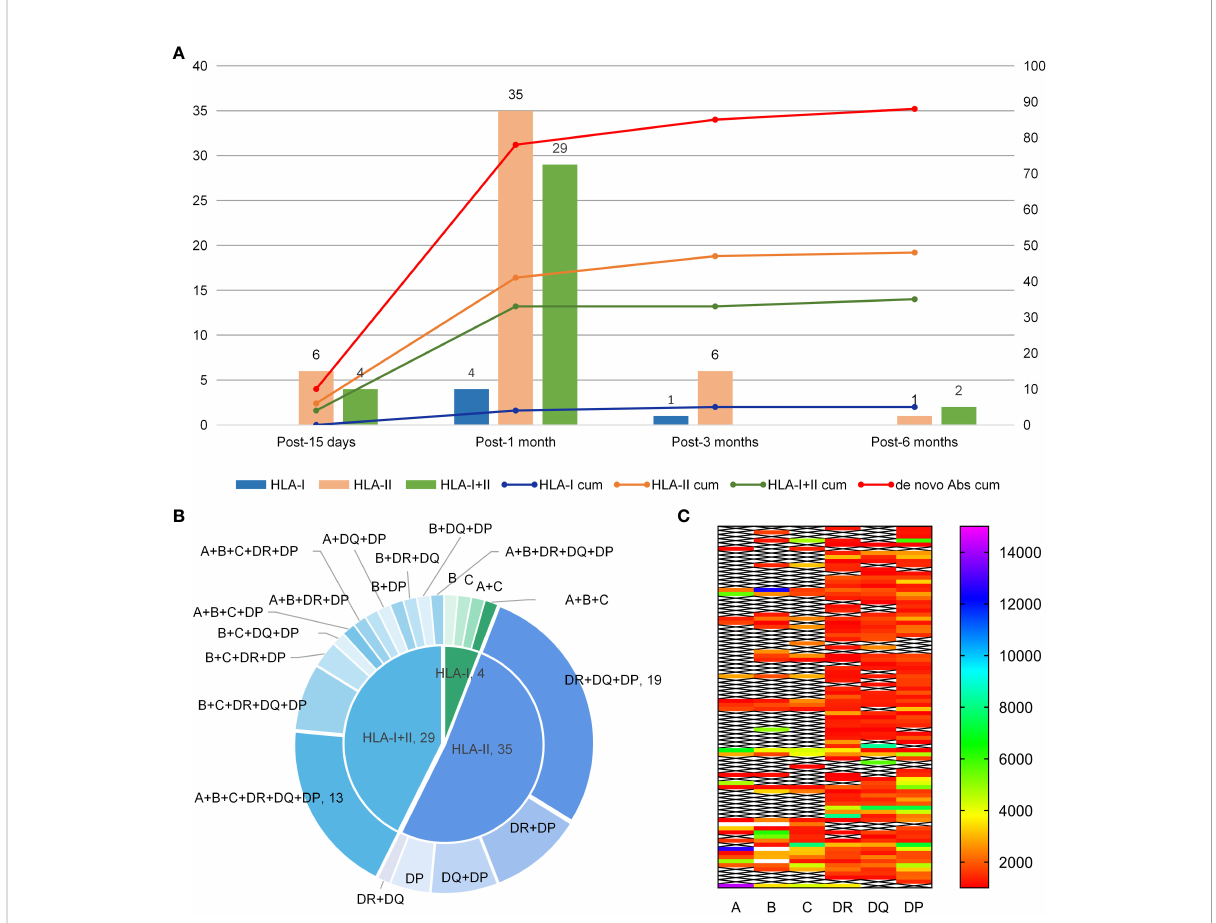
FIGURE 1 Production time, type, and MFI level of de novo HLA antibodies. (A) Type of de novo HLA antibodies detected at different times after haplo- HSCT. The Y-axis represents the quantity of de novo HLA antibodies. The bars correspond to the left Y-axis; the lines correspond to the right Y- axis and represent the cumulated quantity of antibodies; cum, reprensents accumulation. (B) Speci fi city of de novo antibodies detected 1 month after transplantation. (C) MFI level distribution of de novo antibodies in 88